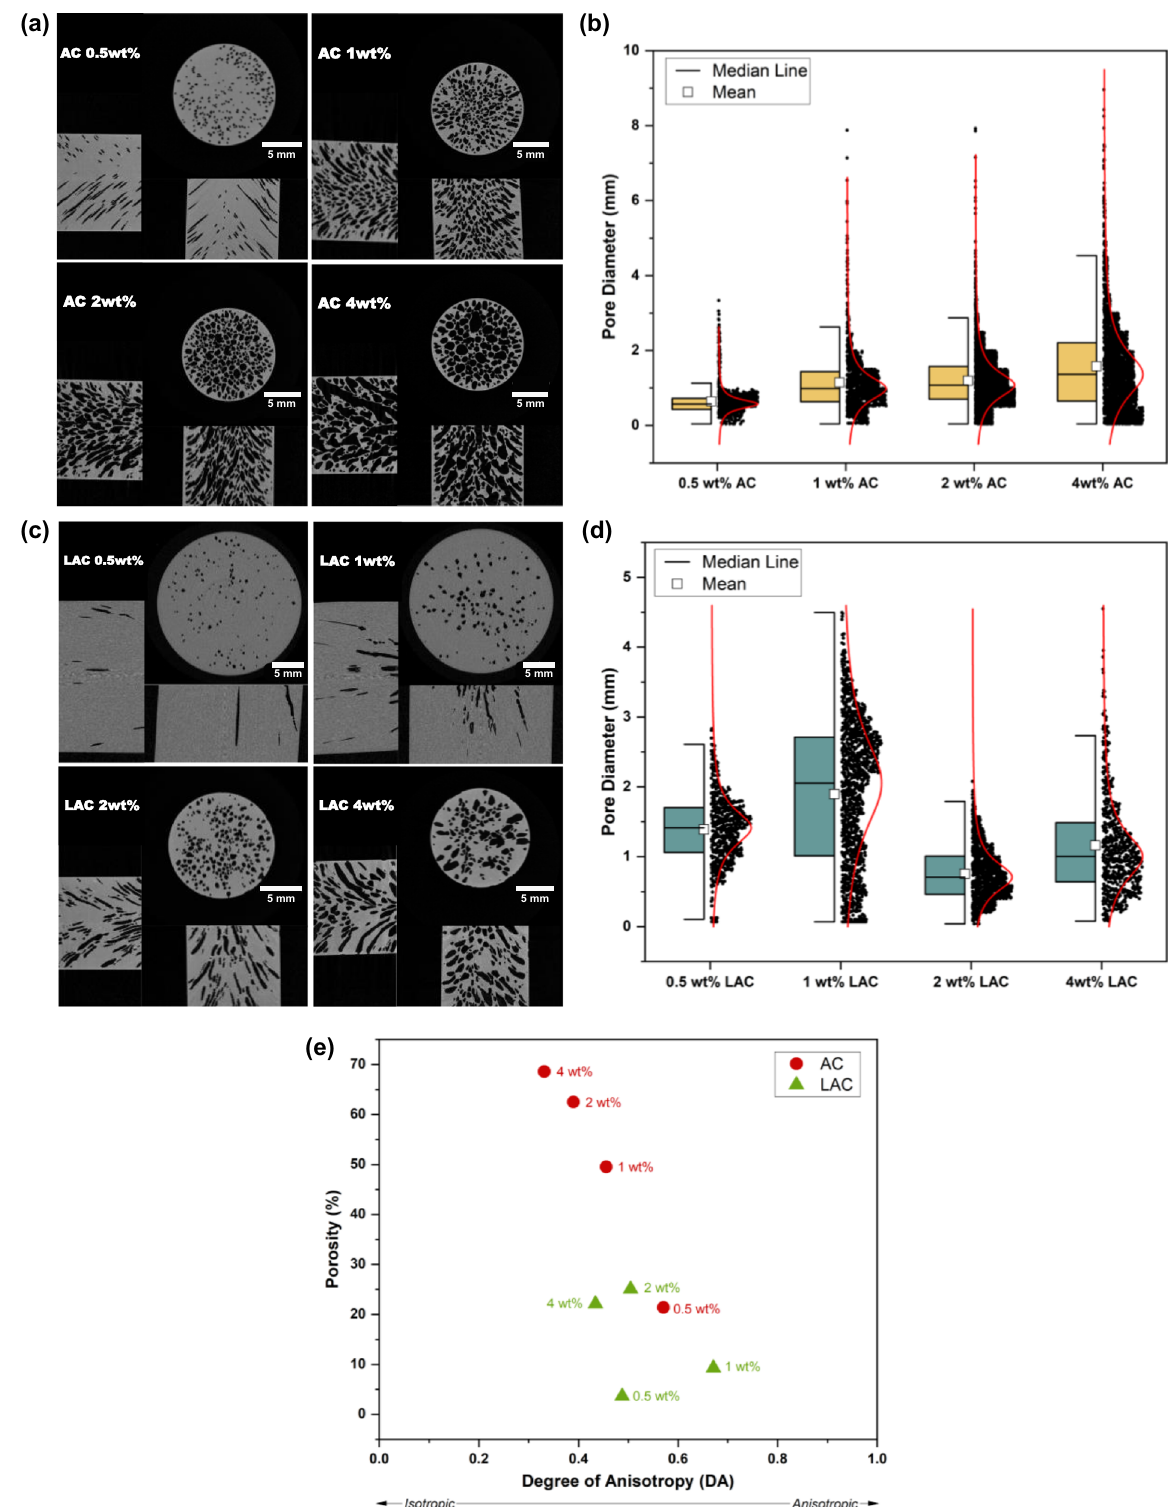
Fig. 3 A directly proportional relationship between % allylation, AC wt%, and the produced pore sizes and organizations was observed. a μ -CT images of DCPD/AC foams at varying AC wt%. b Box plot of the DCPD/0.5-4 wt% AC foam pore sizes and their homogenous distribution. c μ -CT images of DCPD/LAC foams at varying LAC wt%. d Box plot of DCPD/0.5-4 wt% LAC foam pore sizes and their heterogeneous distribution. e A plot showing the relationship between the % porosity and degree of anisotropy of DCPD/AC and -LAC